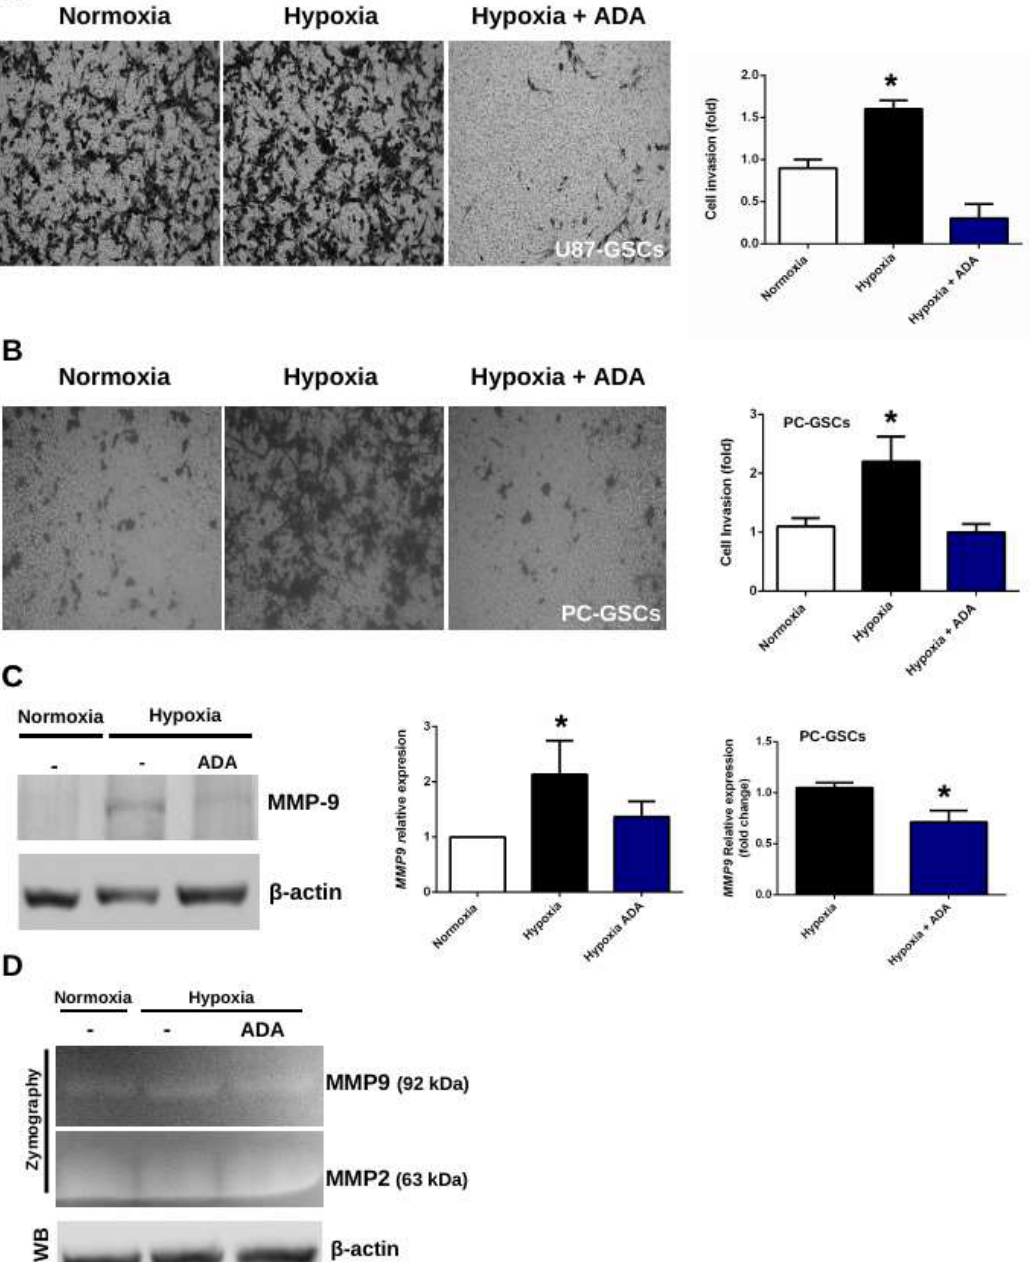
Figure 4. Effects of adenosine depletion on GSCs invasiveness. ( A ) Matrigel-coated transwell invasion assay of U87-GCSs in absence or presence of 1 U/mL ADA for 12 h. Cell invasion was plotted as fold change of the normoxic condition. ( B ) Same as in a but using PC-GSCs. ( C ) MMP-9 protein levels of U87-GSCs were analyzed by western blot and transcript levels of U87-GSCs and PC-GSCs were analyzed by RT-qPCR in the same treatmentconditions of A . (D) MMPs gelatinase activity was measured by zymography assay with GSCs extracellular medium. n = 3 * p < 0.05. 3.5. Adenosine Depletion Decreases GSCs In Vitro Tumorigenicity and Vincristine Chemoresistance MRPs-mediated chemoresistance assays were performed under normoxia. ADA decreased MRPs extrusion capacity of a fluorescent substrate (CDFA), which is accumulated inside the cells by